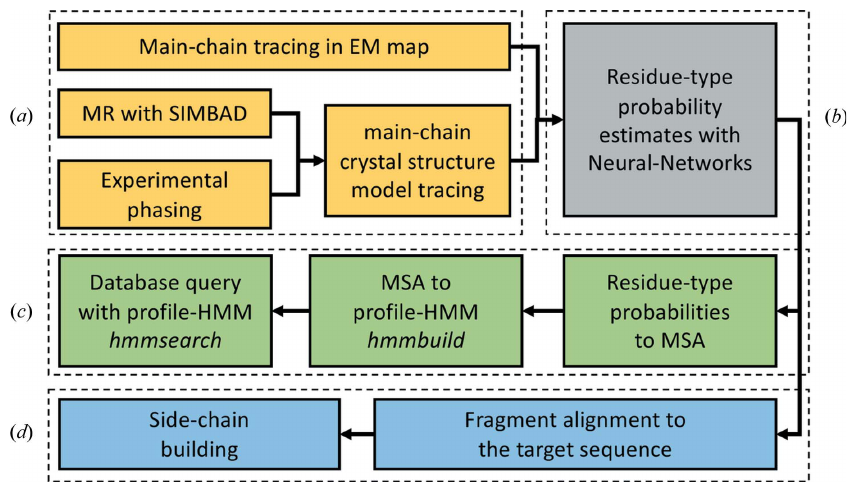
Figure 1 A schematic representation of the findMySequence usage workflow. Key steps are grouped in dashed rectangles: ( a ) structure solution and model building, ( b ) model interpretation, ( c ) sequence-database queries, and ( d ) sequence assignment and model building. All steps except model tracing ( a ) are integrated in the software and performed